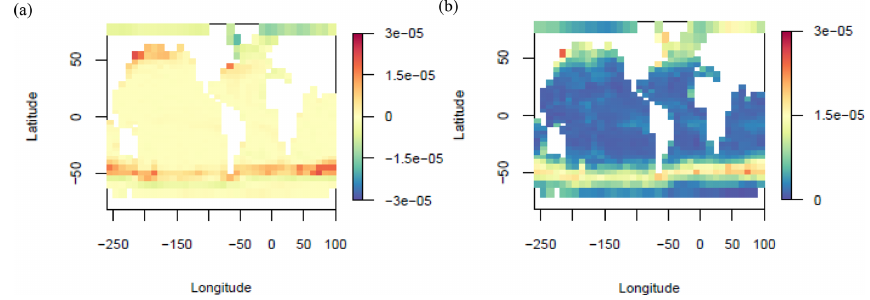
Figure 16. LGM deep-sea CaCO 3 burial rate change (molcm − 2 yr − 1 ) ENS 104 mean (a) and standard deviation (b)